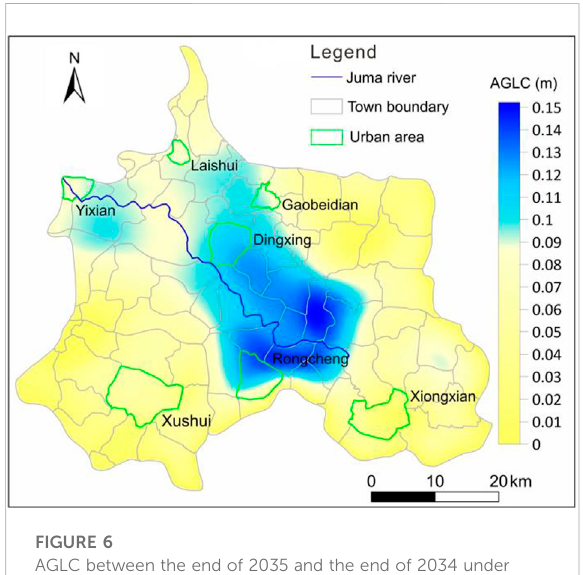
FIGURE 6 AGLC between the end of 2035 and the end of 2034 under the condition of groundwater pumping